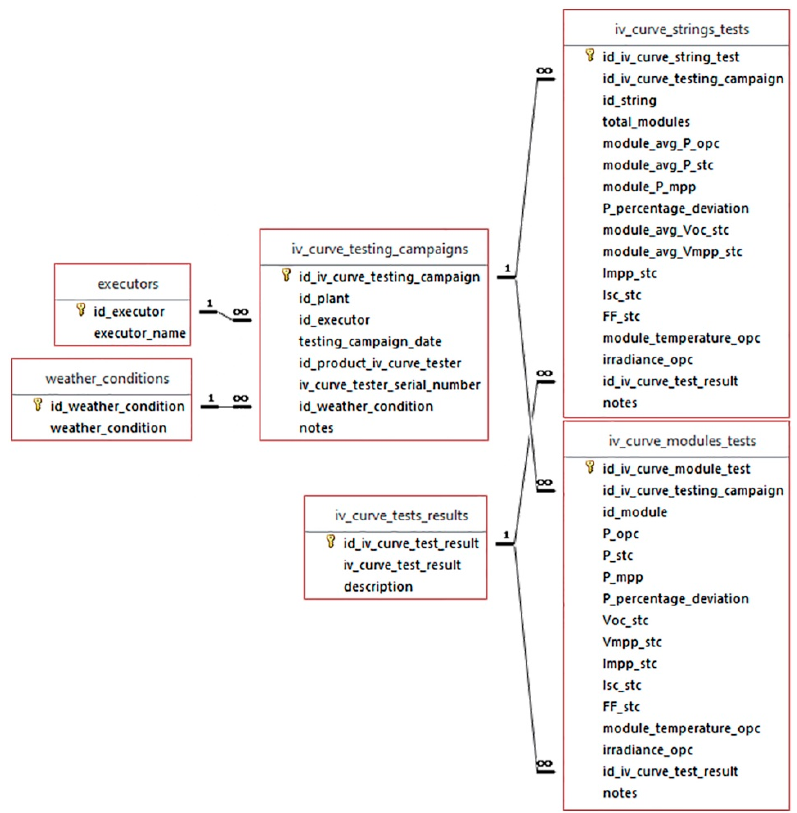
Figure 12. The IV curve tests group of the relational database.